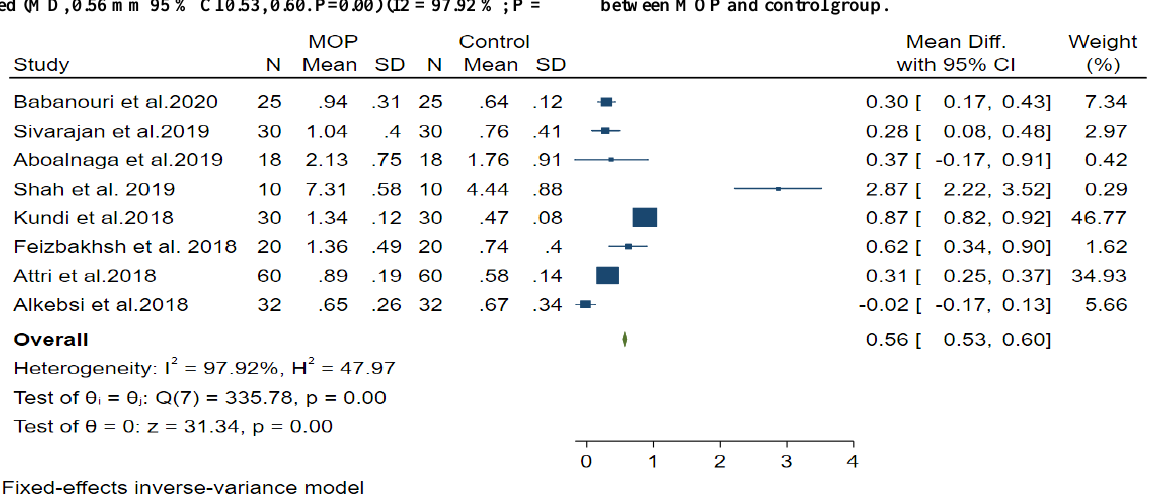
Fig. 2. Mean difference of orthodontic tooth movement with MOP vs whiteout